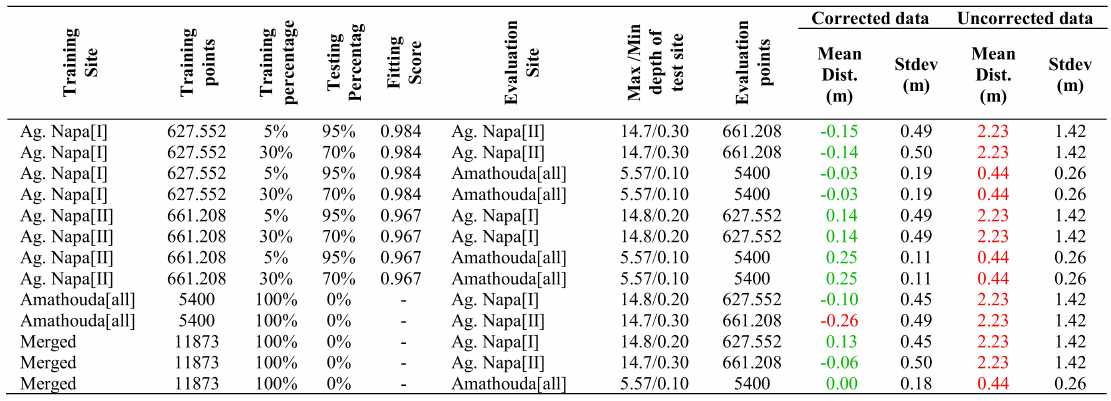
Table 3. The results of the comparisons between the predicted models for all the tests performed.